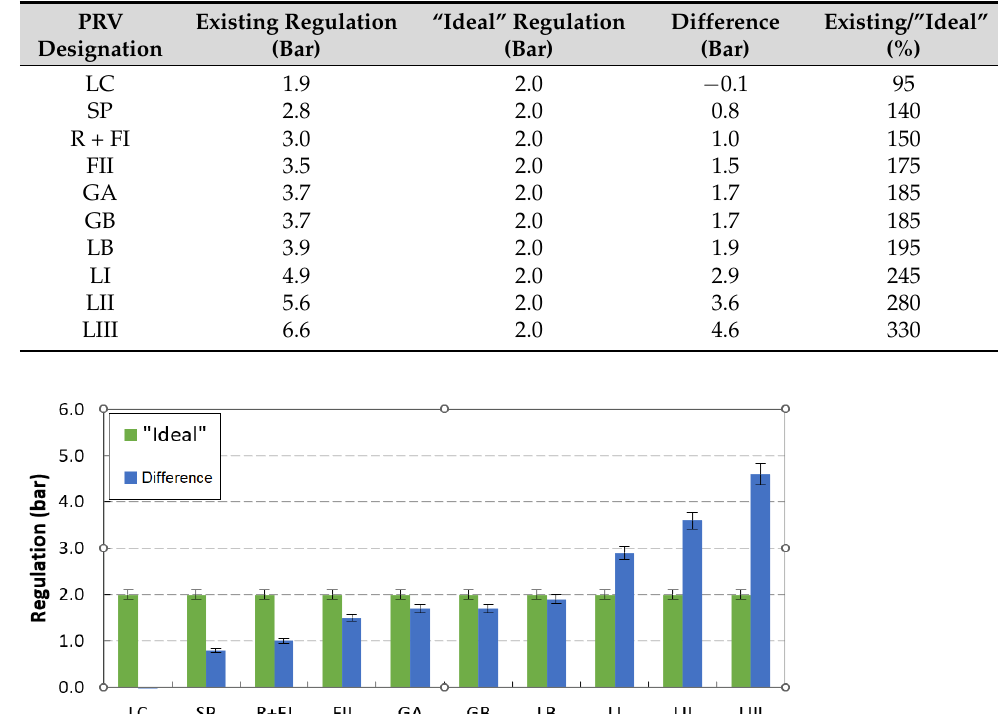
Table 4. Existing PRV characteristics in the Gaula WDS.